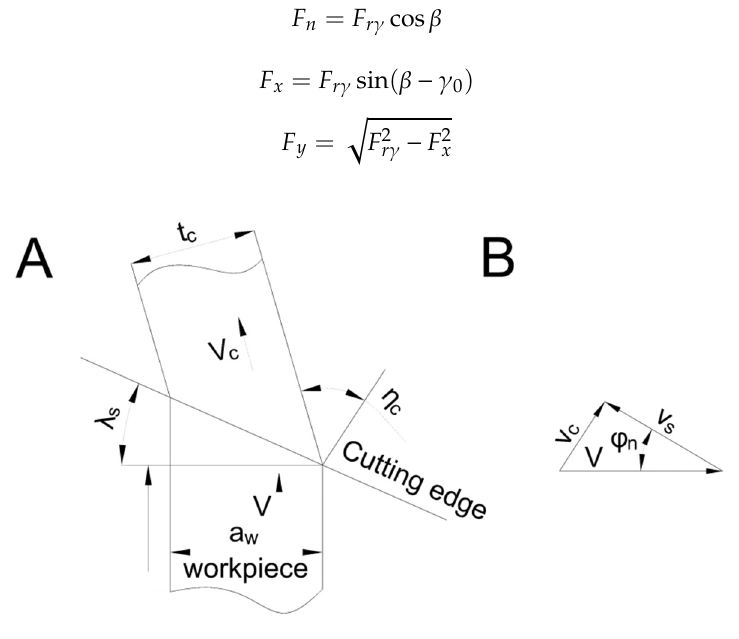
Figure 4. ( A ) Bevel cutting model. ( B ) Velocity vector triangle.